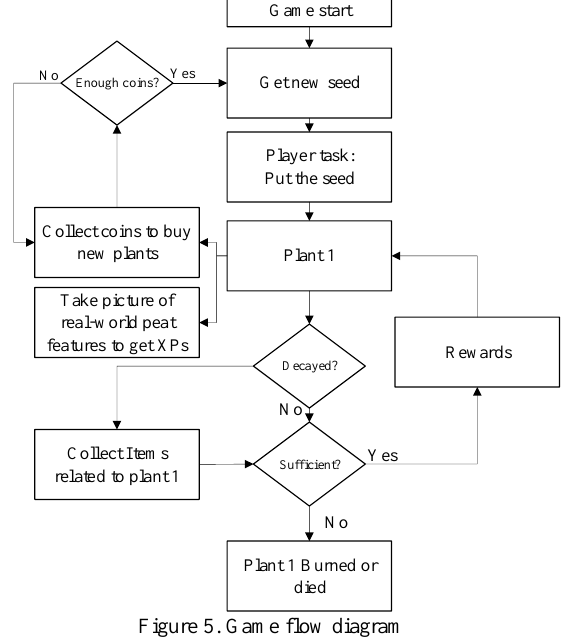
Figure 5. Game flow